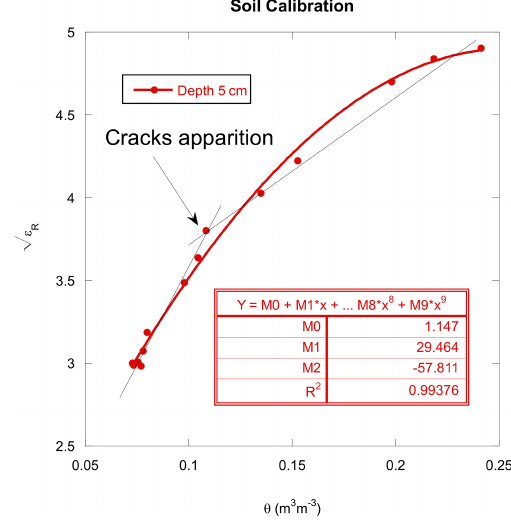
Figure 4. Typical calibration relating the square root of the real part of relative dielectric permittivity to the real volumetric SWC (FR- Aur, pit D, depth 5cm). For the purpose of this study, second-order polynomial regression was used for calibration (in